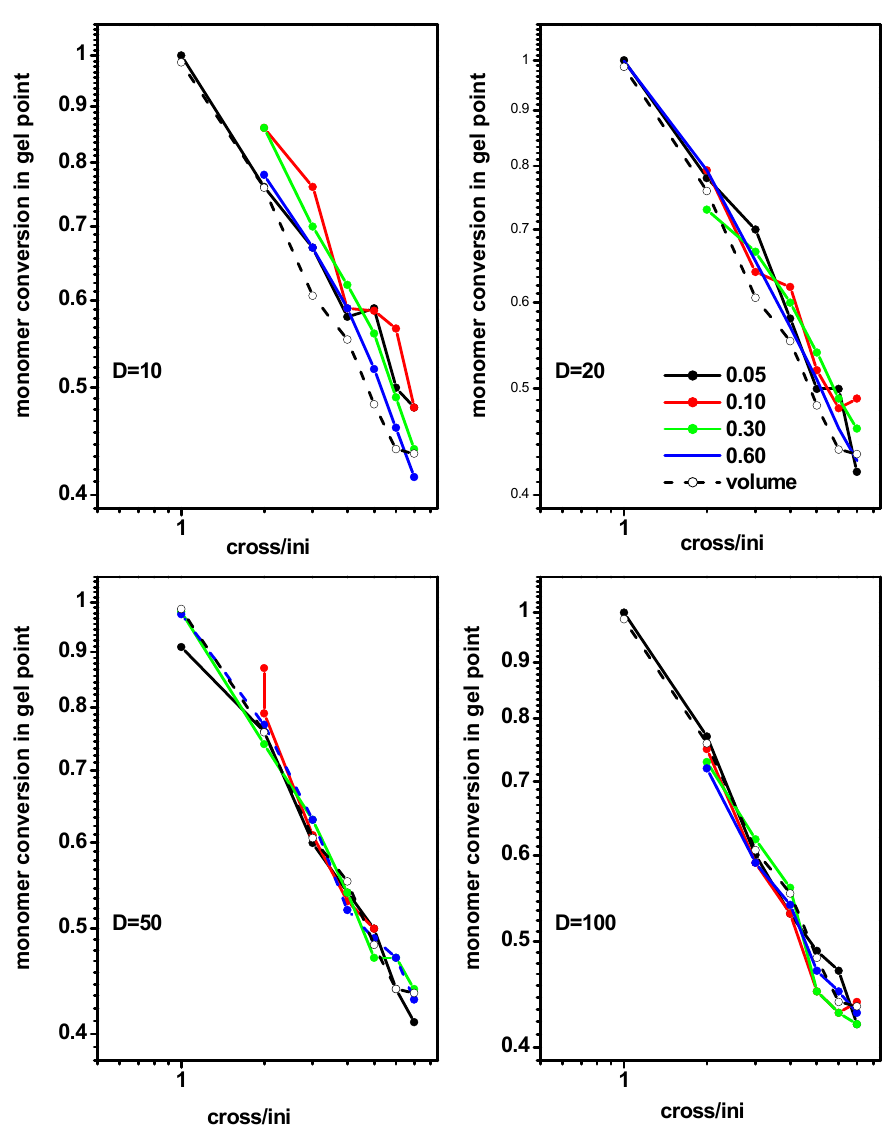
Figure 6. Monomer conversion at the gel point for the polymerization in a slit as a function of the ratio [Ini]/[X] for different widths of the slit. The initiator densities are given in the inset. The monomer conversion at gel point for a free volume is marked by the dashed line.